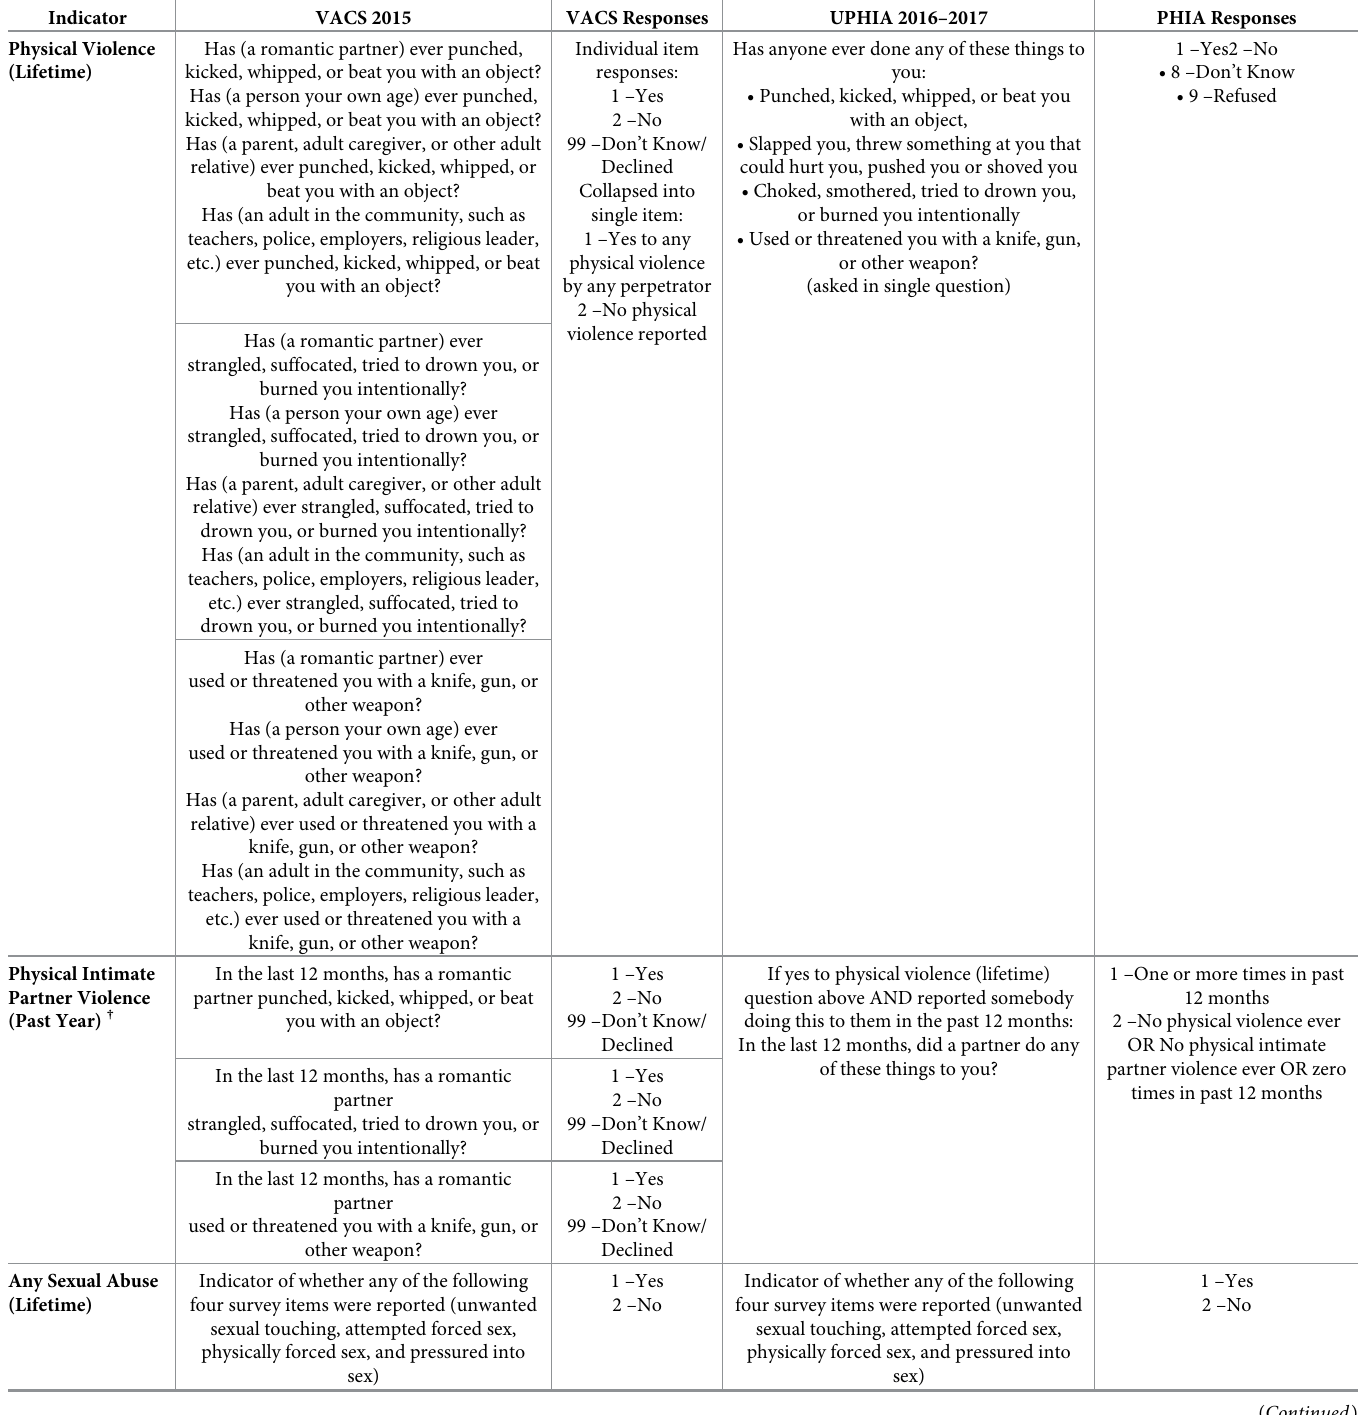
Table 2. Wording and response options of comparable violence questionnaire items between Uganda Violence Against Children Survey (VACS 2015) and Uganda Population-based HIV Impact Assessment (UPHIA 2016–2017) � .